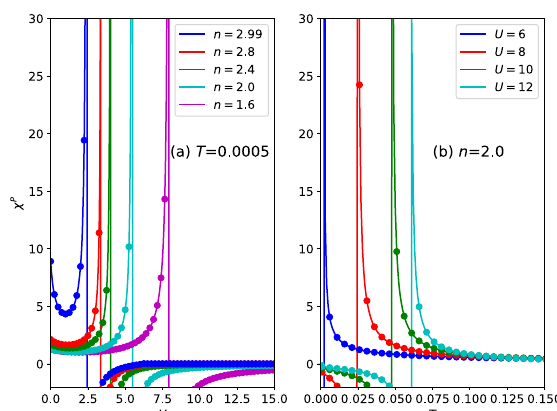
FIG. 9. Comparison of the pairing susceptibilities χ P computed from Eq. (42) (solid line, without “ quasiparticle constraint ” ) and Eq. (56) (filled circles, with “ quasiparticle constraint ” ) for (a) T ¼ 0 . 0005 and n ¼ 2 . 99 , 2.8, 2.4, 2.0, 1.6 as a function of U and J ¼ U= 4 , and (b) n ¼ 2 . 0 and U ¼ 6 , 8, 10, 12 as a function of T and J ¼ U= 4